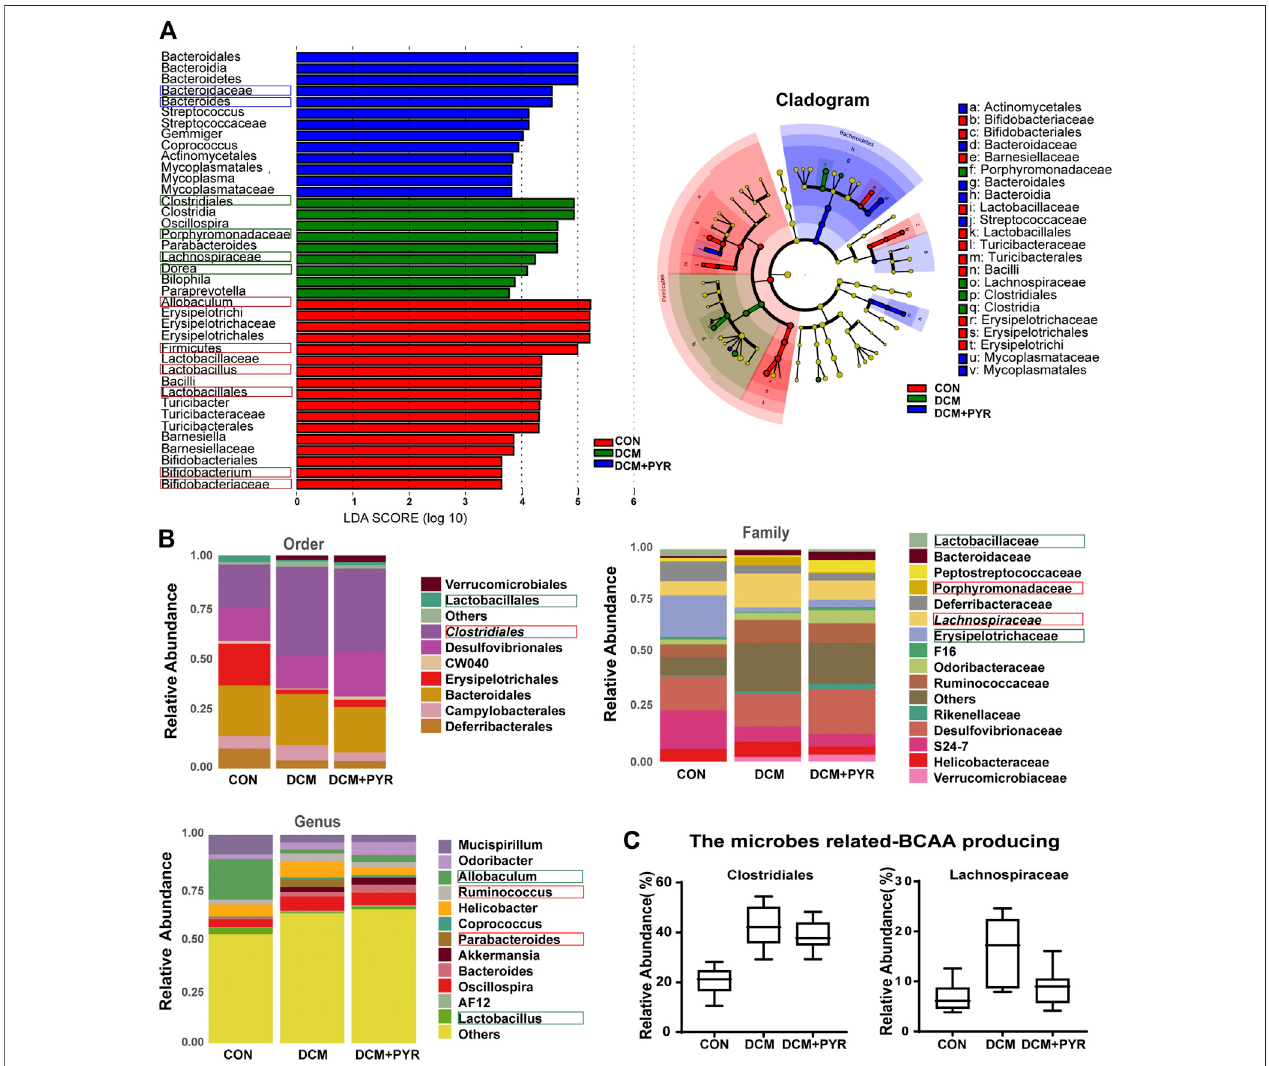
FIGURE 4 | Gut microbiota composition was affected after pyridostigmine supplementation in diabetic cardiomyopathy mice. (A) Differences in the bacterial communitiesobtainedbyLEfSeanalysisofthe16 Ssequences. (B) Order-level,family-level,andgenus-leveltaxonomicdistributionsofthegutmicrobiota. (C) Effectsof pyridostigmine treatment on the relative abundance (%) of gut microbes related to BCAA production, including Clostridiales and Lachnospiraceae . Data are expressed as the mean ± SEM. n (cid:1) 8.